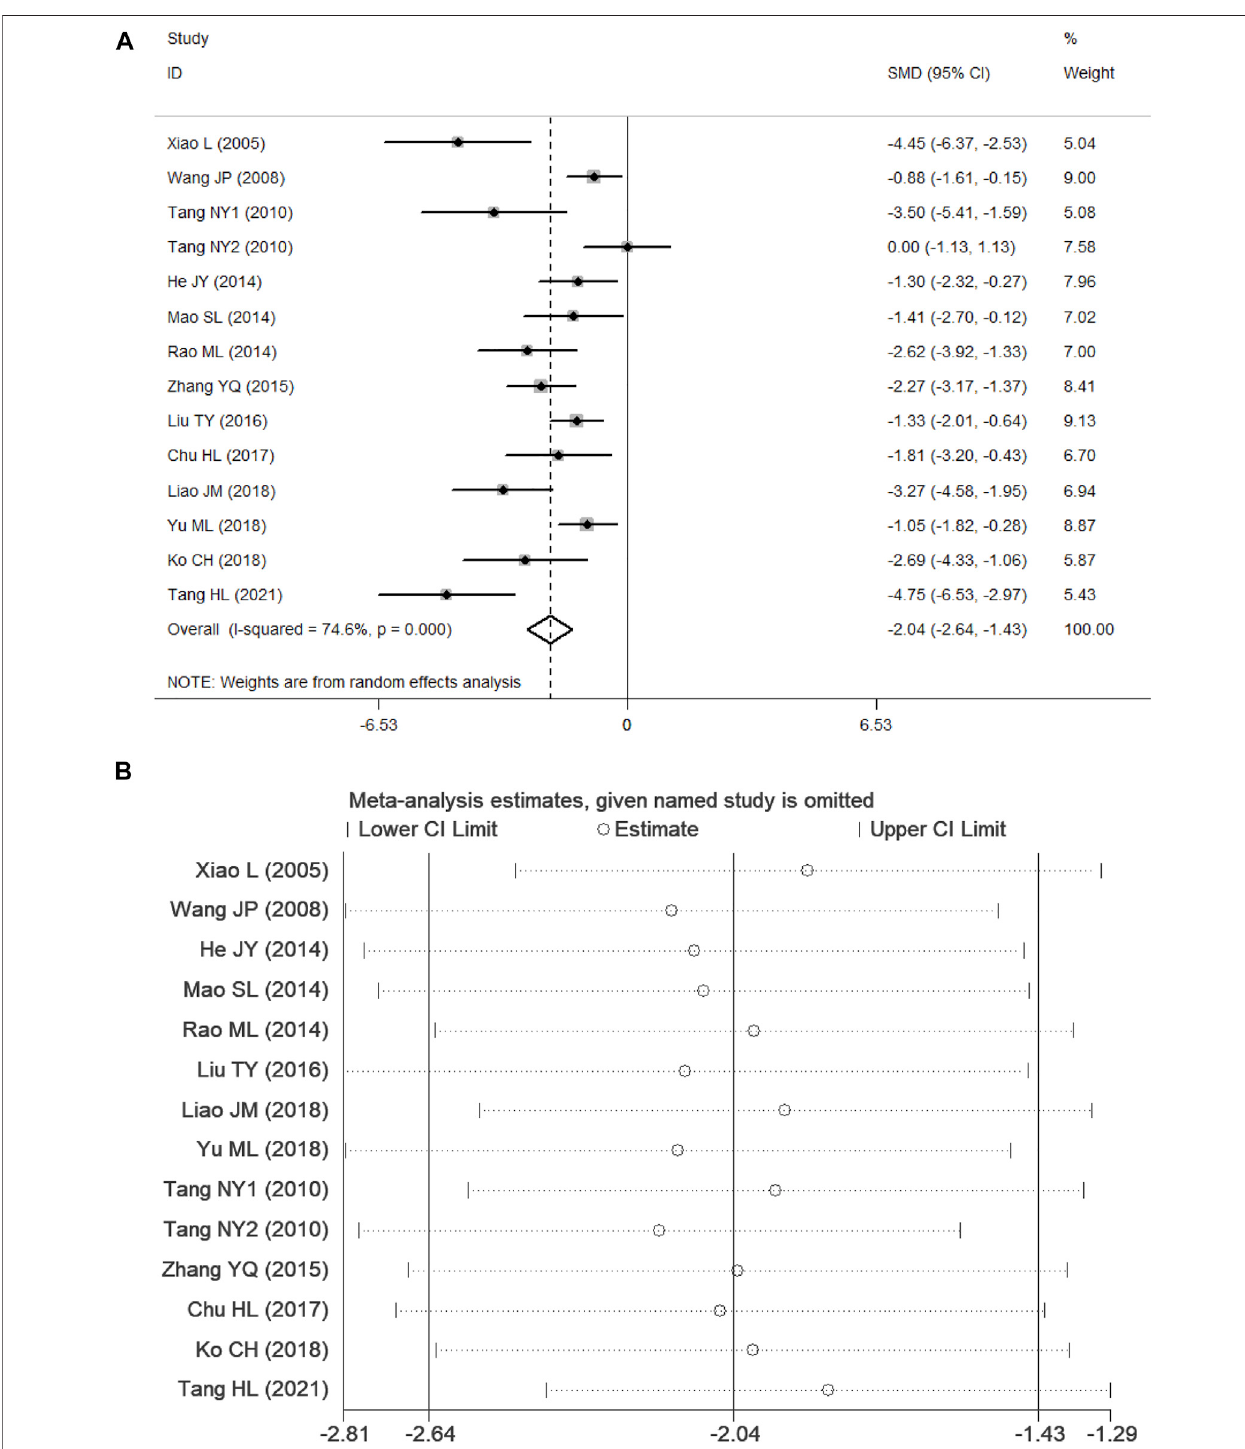
FIGURE 4 | Forest plots of PF for NSS. (A) Effects of PF on decreasing the NSS in comparison with the control group; (B) sensitivity analysis of PF for NSS.